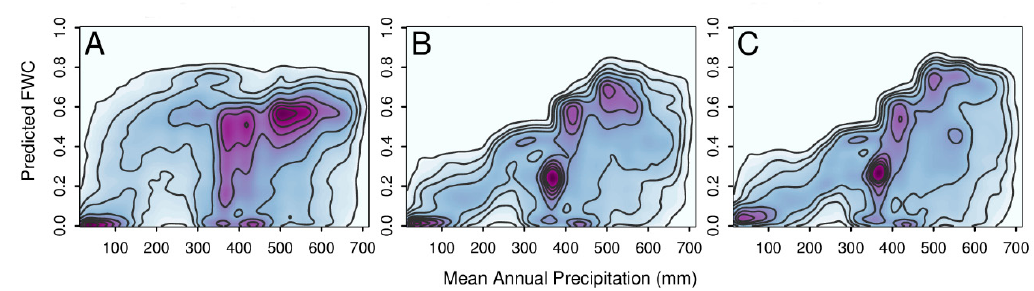
Figure 8. Density plot of mean annual precipitation (MAP) and fractional woody cover (FWC) predicted by random forest models including, ( A ) SAR only (no ancillary variables), ( B ) MAP, and ( C ) elevation and MAP.